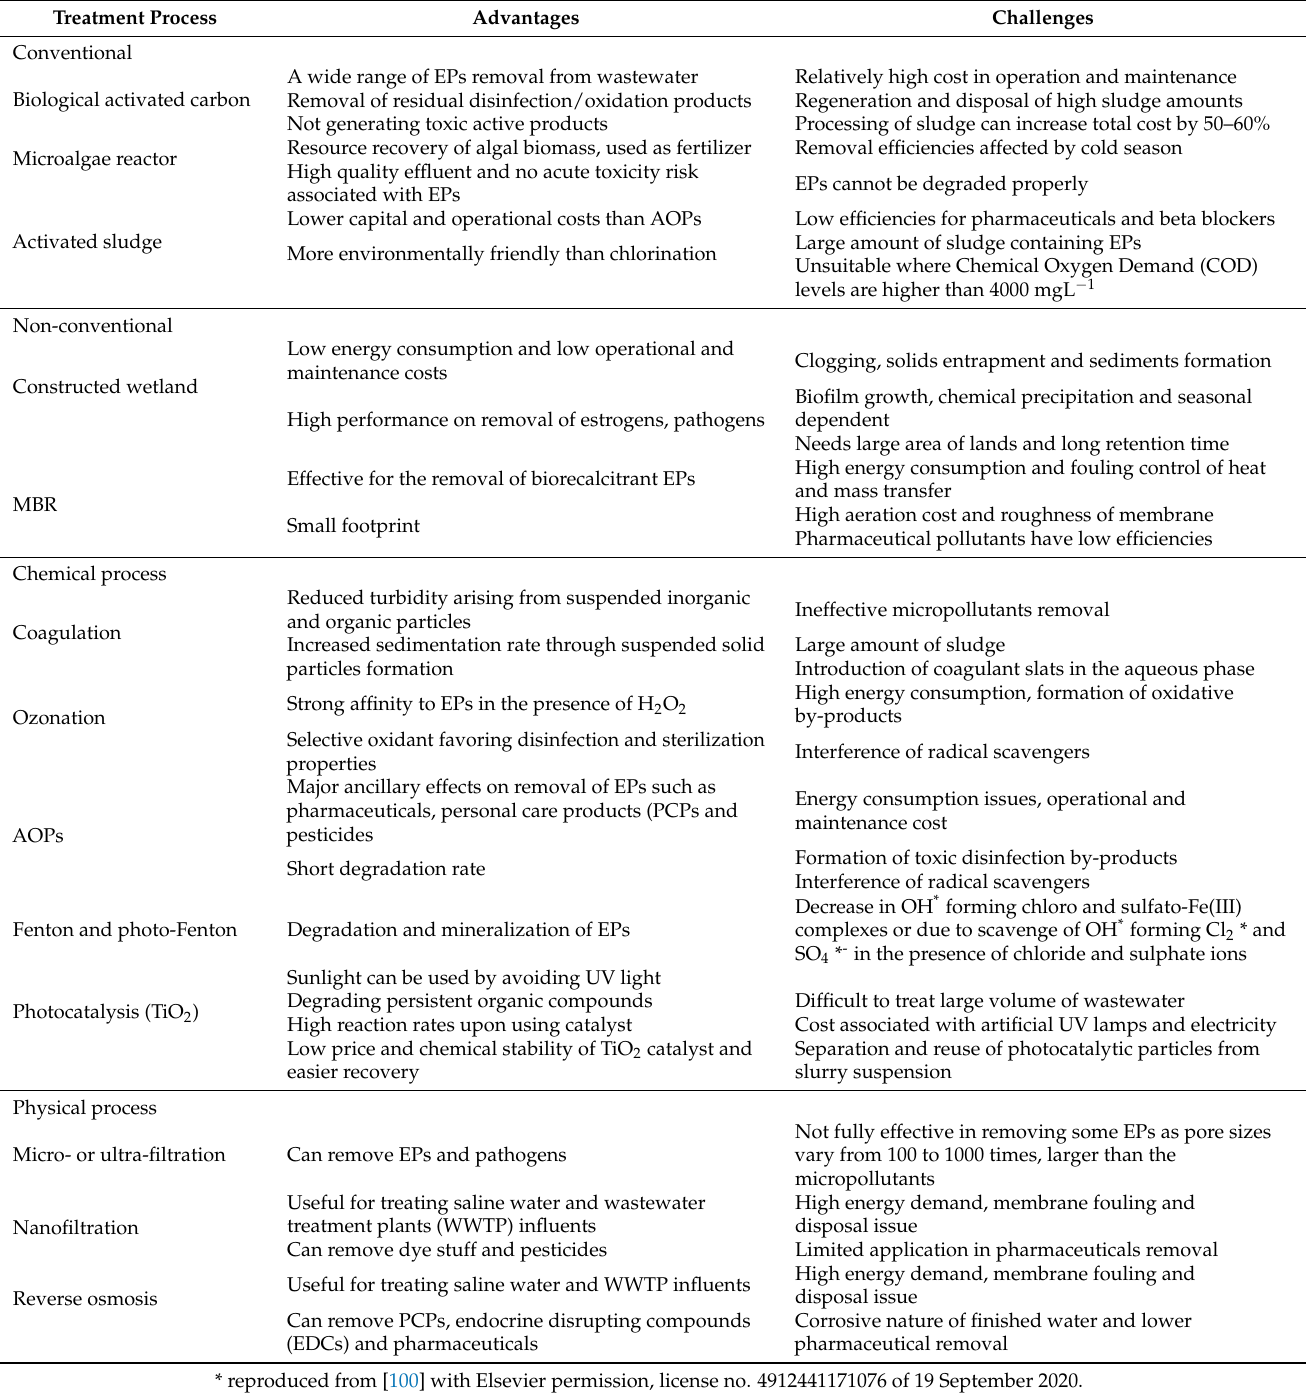
Table 5. Advantages and challenges of different technologies in the removal of emerging pollutants [100]